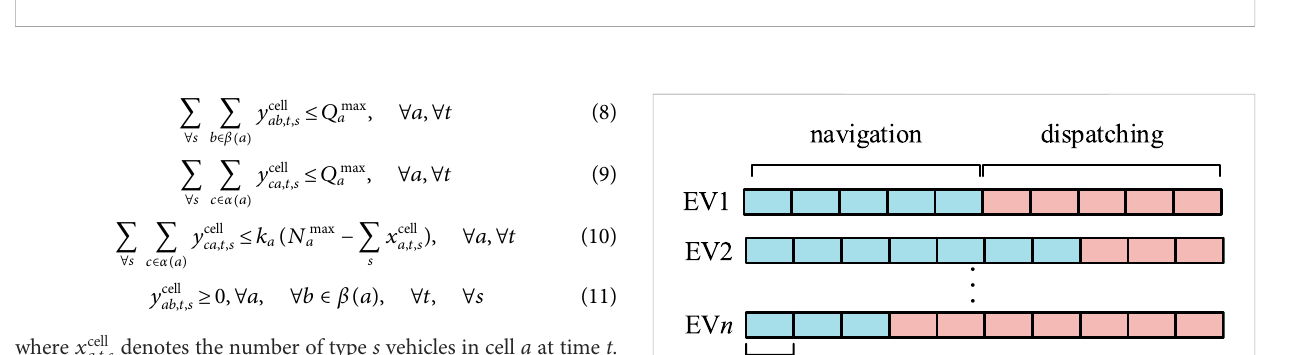
FIGURE 2 Conversion to cell structure.